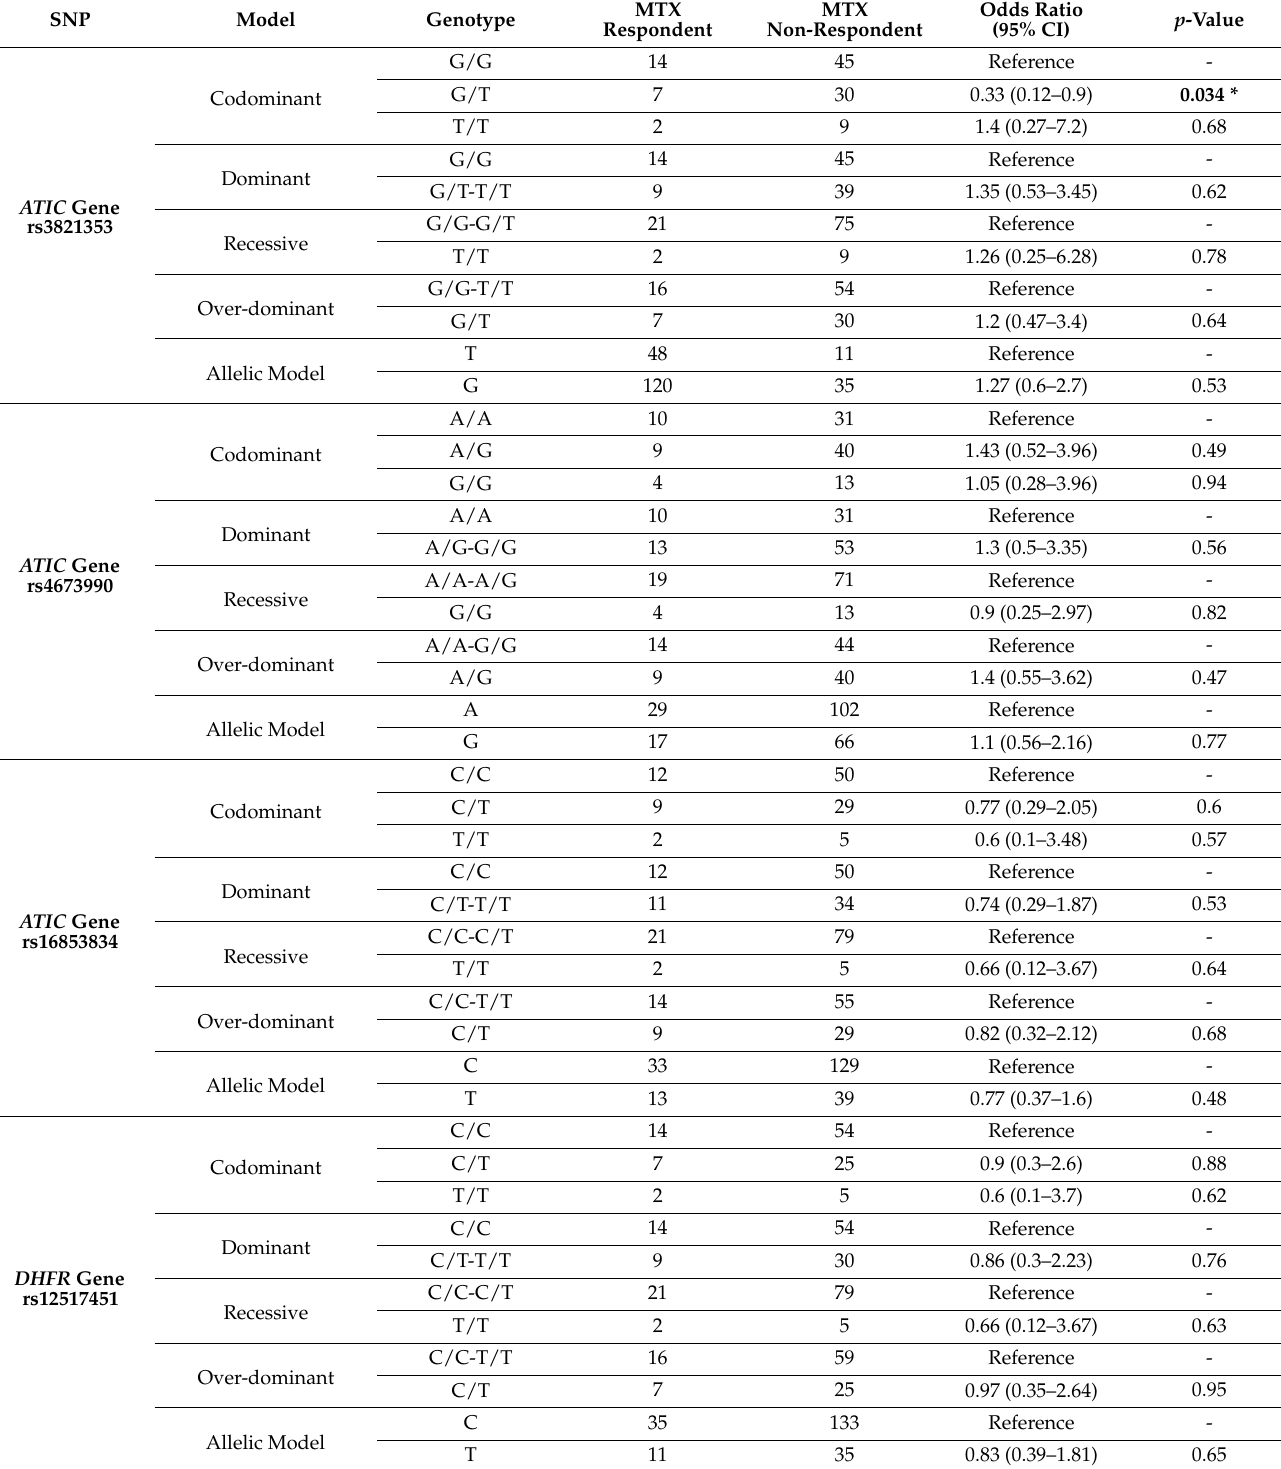
Table 5. Genetic association models for methotrexate pathway genes with the treatment response to